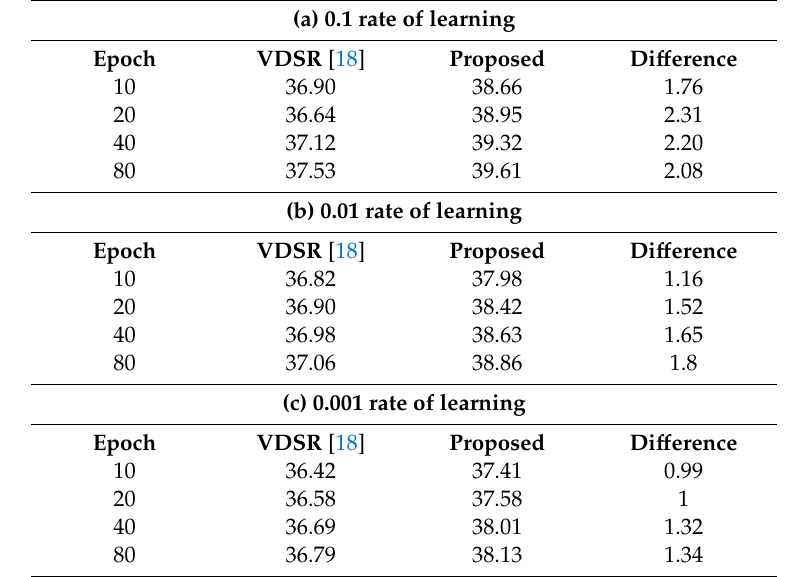
Table 1. Performance table (peak signal-to-noise ratio, or PSNR) for the proposed and VDSR [18] networks (“Set5” dataset, × 2).